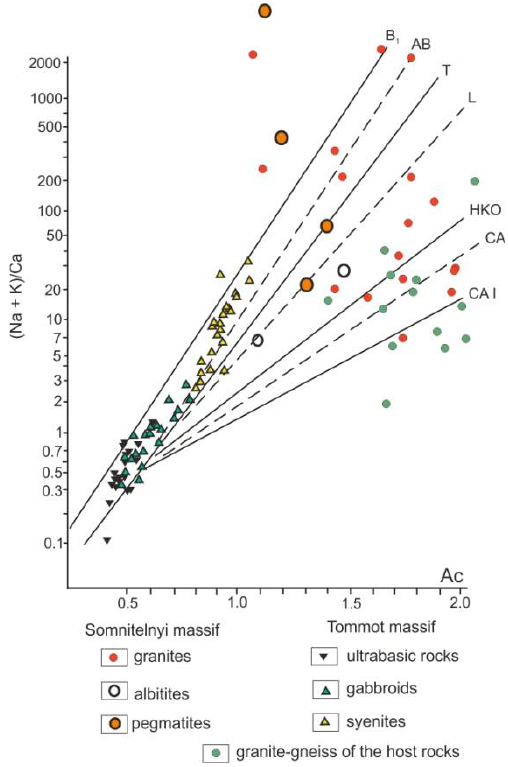
Figure 9. (Na + K)/Ca vs. Ac diagram for rocks of the Tommot ore field. Symbols [51,52]: Ac — cation activity (Ac = 4Si/ Σ (Me × Bc), where Me = amount of cations of rock-forming oxides × 1000; Bc—basicity of cations; Σ (Me × Bc)—sum of (Me × Bc) for each major oxide except for SiO 2 [51,52]; evolution trends: CAI—calc-low-alkaline (island-arc); CA—calc-alkaline (collision); HKO—high- potassium (orogenic), L—latitic; T—trachytic; AB—alkaline-basaltic; B 1